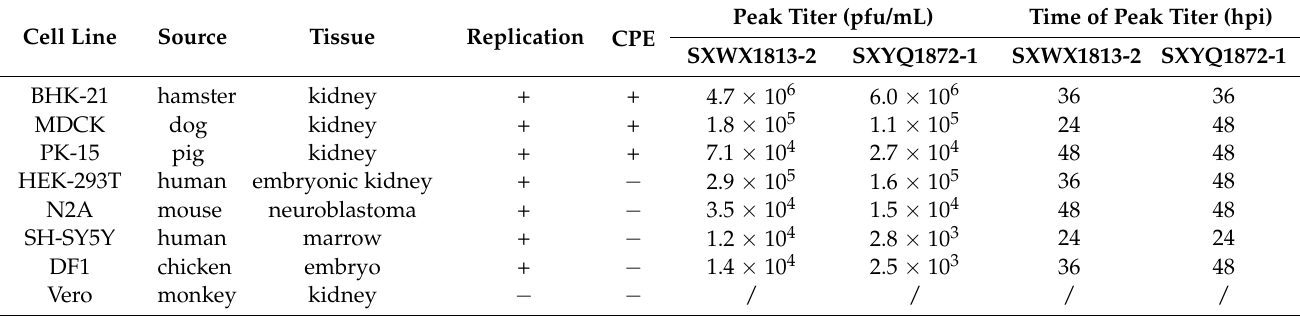
Table 1. Cell lines tested for WUXV infection